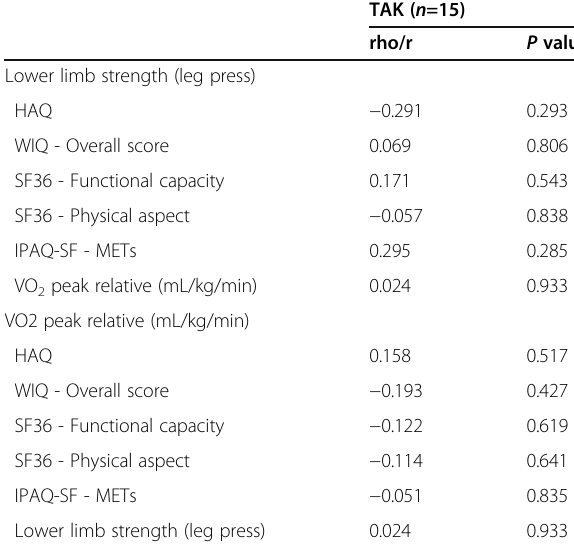
Table 6 Correlation between functional variables, lower limb strength and peak relative VO 2 of patients with